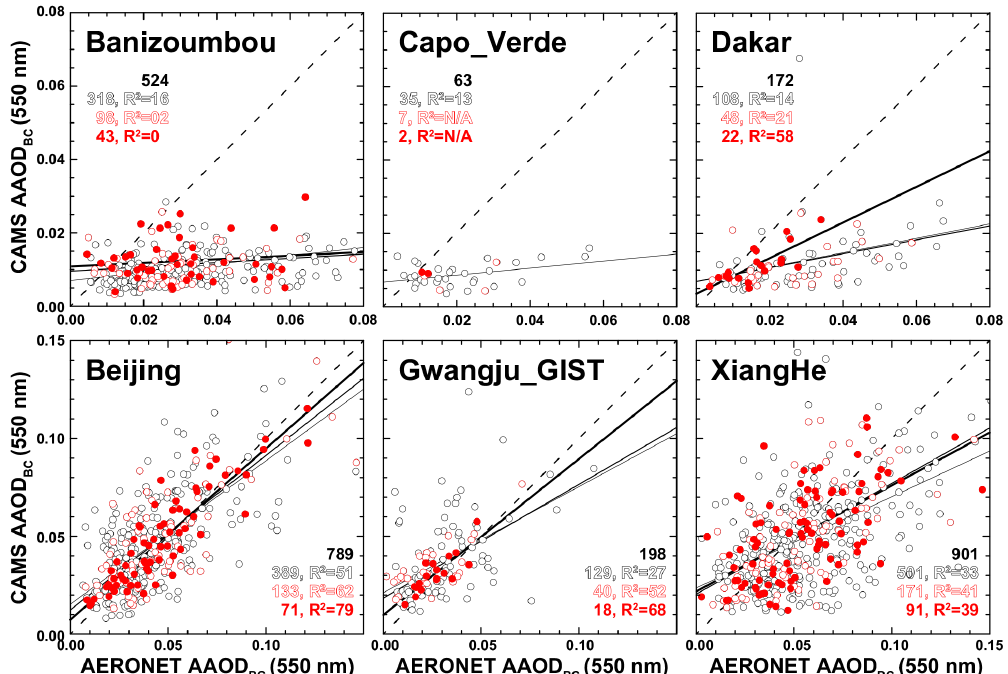
Figure 8. Comparison of AERONET-derived AAOD BC with CAMS model estimates for the sites listed in Table 2 for cases in which the total AOD from CAMS and AERONET agrees within 30% (black circles, thin lines), 10% (red circles, medium lines), and 5% (red dots, bold lines). Numbers in the plots refer to the total number of collocated points and the number of matches with the given AOD agreement. Dashed lines mark the 1:1 line. Solid lines are linear fits of the data. Numbers in the plots refer to the number of collocations and squared correlation coefficients for all cases (solid black) and those with an AOD agreement within 30% (open black), 10% (open red), and 5% (solid